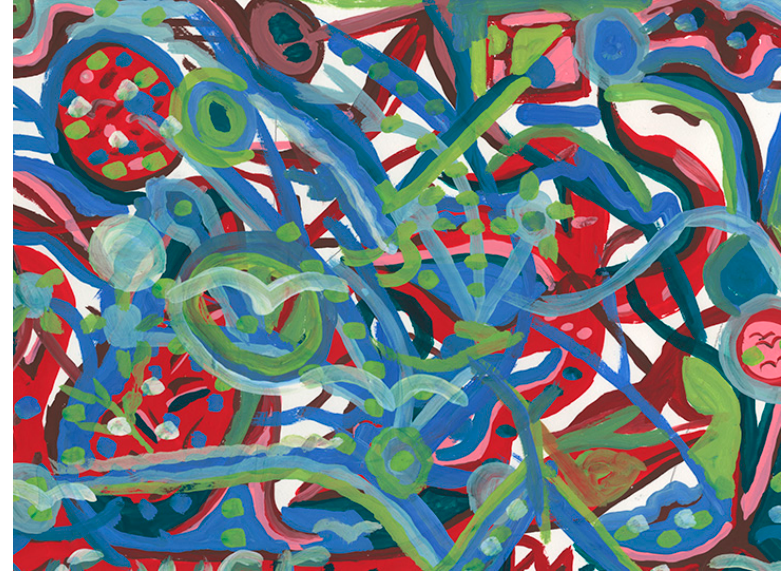
Figure 8. Marcella (aged 41, borderline personality disorder), Agitation.